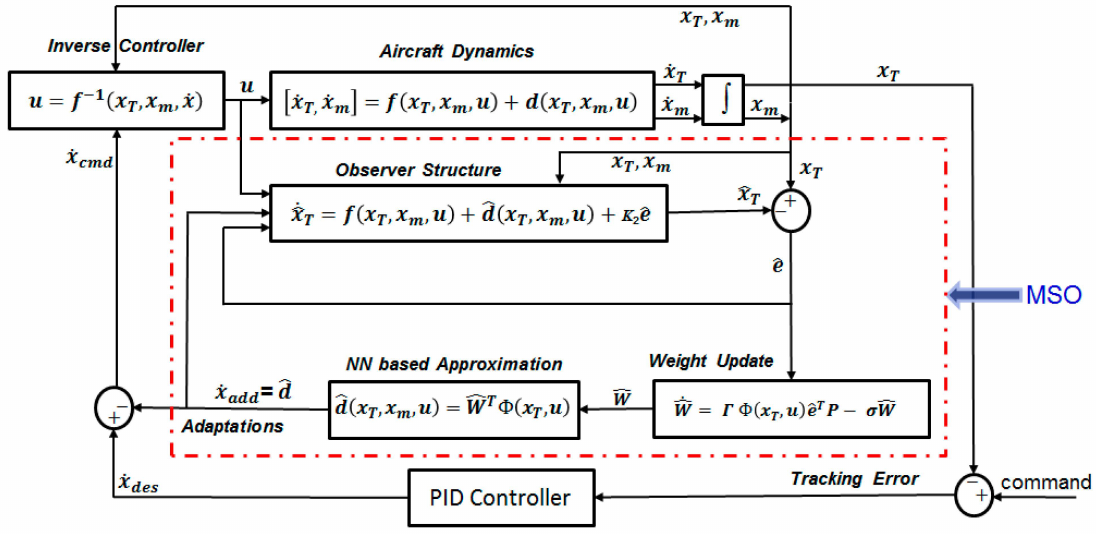
Figure 1. Block diagram of modified state observer architecture.